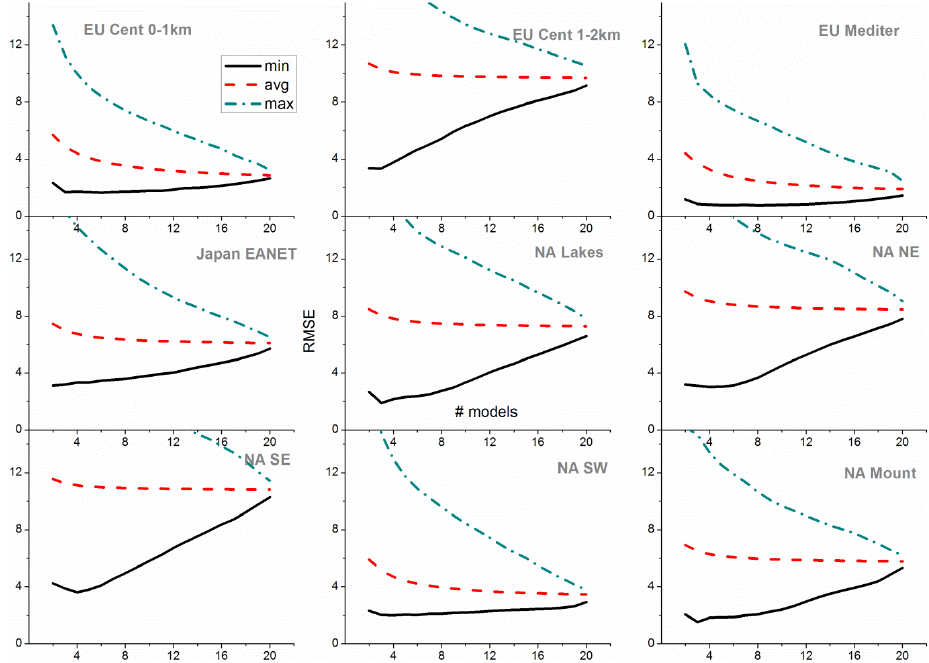
Figure 3. Maximum (dash-dotted), average (dashed), and minimum (continuous line) RMSE for all subsets of MM combinations and for the nine subregions subject to MM ensemble evaluation.